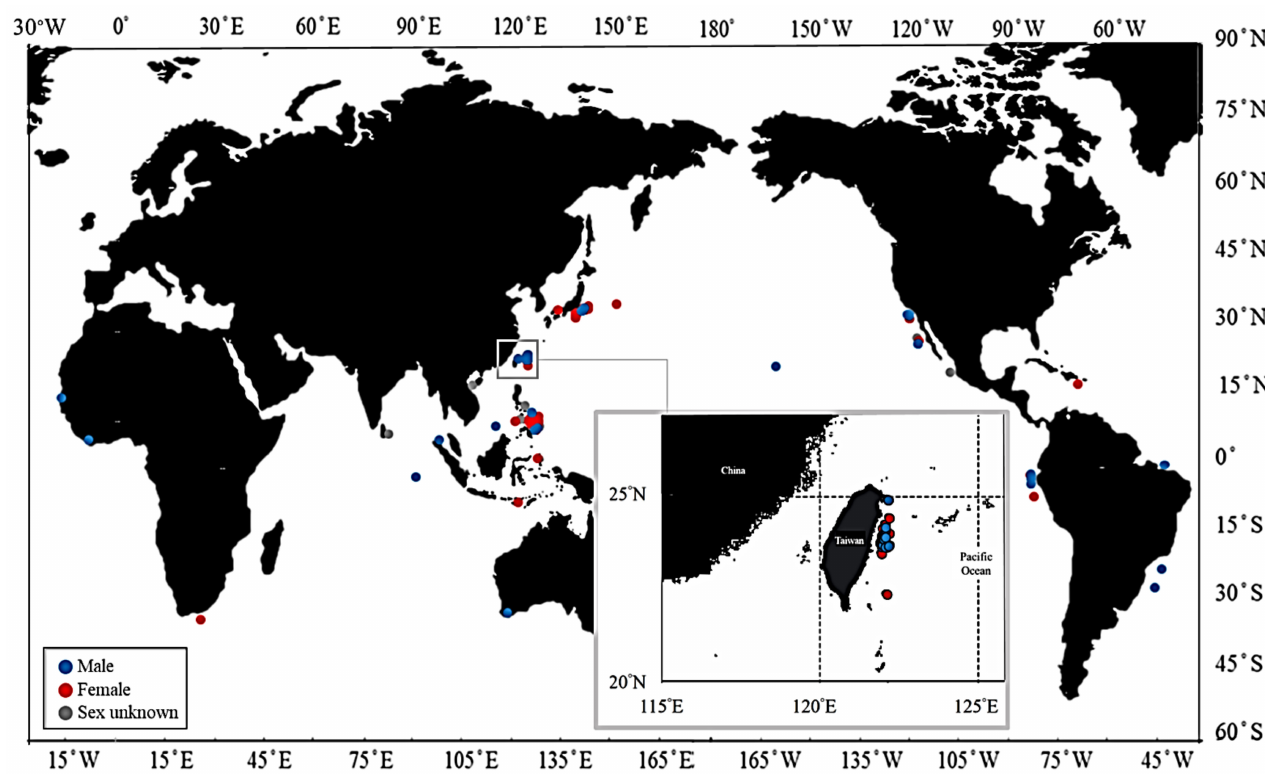
Figure 2. Records of M. pelagios in the world and in the eastern Taiwan